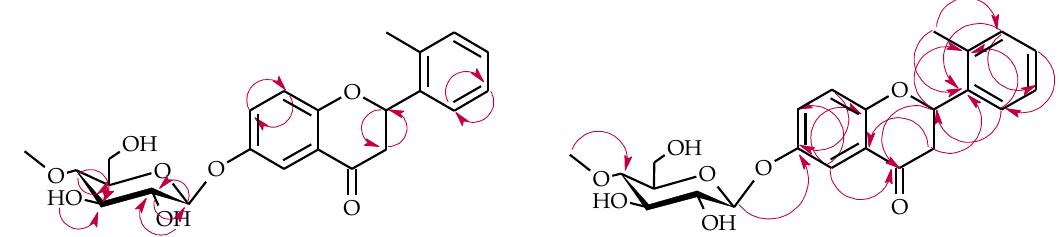
Scheme 3. Key COSY (on the left) and HMBC (on the right) correlations for the structure elucidation of product 4a .